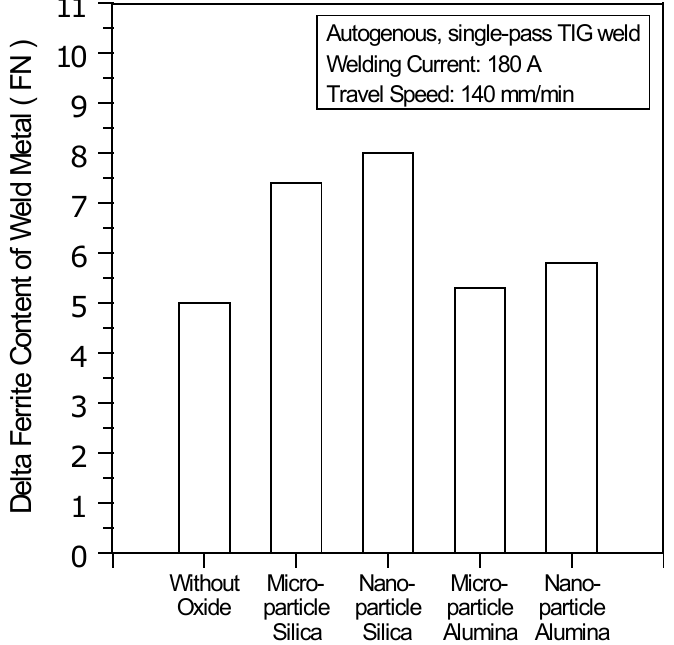
Figure 9. Delta ferrite content of TIG weld metals made with and without